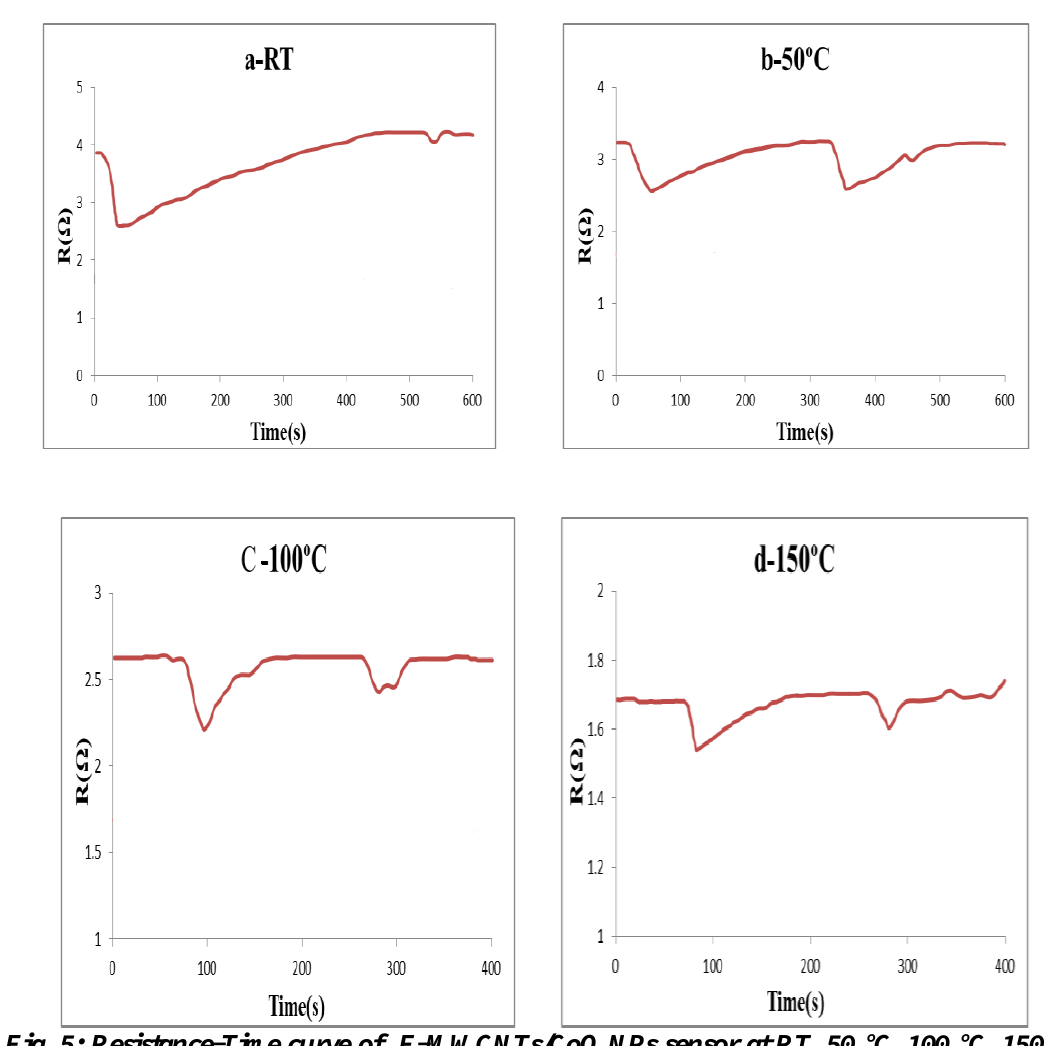
Fig. 5: Resistance-Time curve of F-MWCNTs/CoO NPs sensor at RT, 50 °C, 100 °C, 150 °C when exposed to NO 2